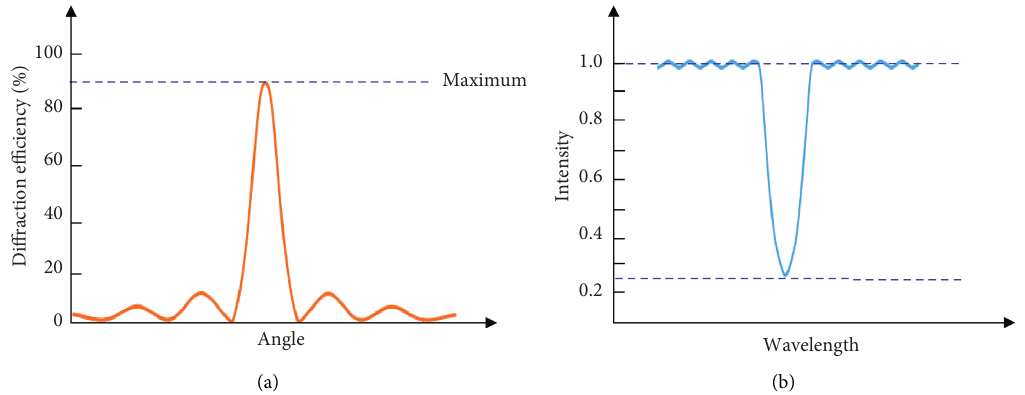
Figure 10: Schematic of reflecting VBGs with (a) angular selectivity and (b) spectral selectivity.